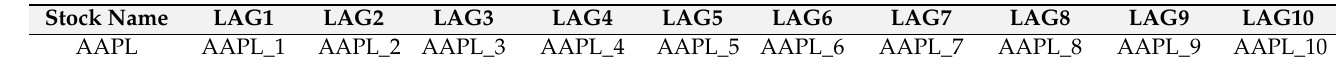
Table 2. The 10 lag features extracted from AAPL stock in the past 10 days.